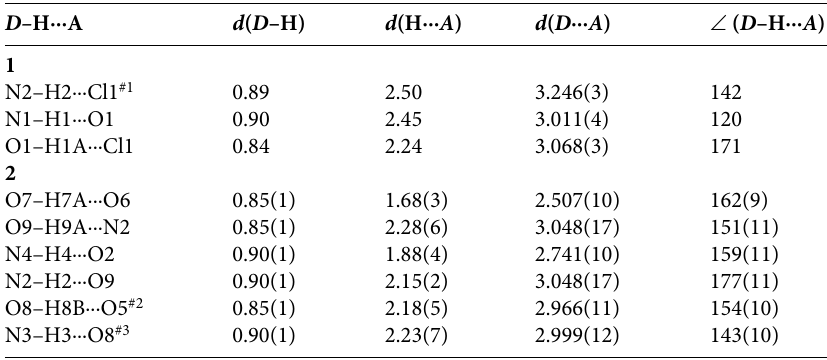
Table 3. Hydrogen bond distances (Å) and bond angles (°) for the complexes D– H∙∙∙A